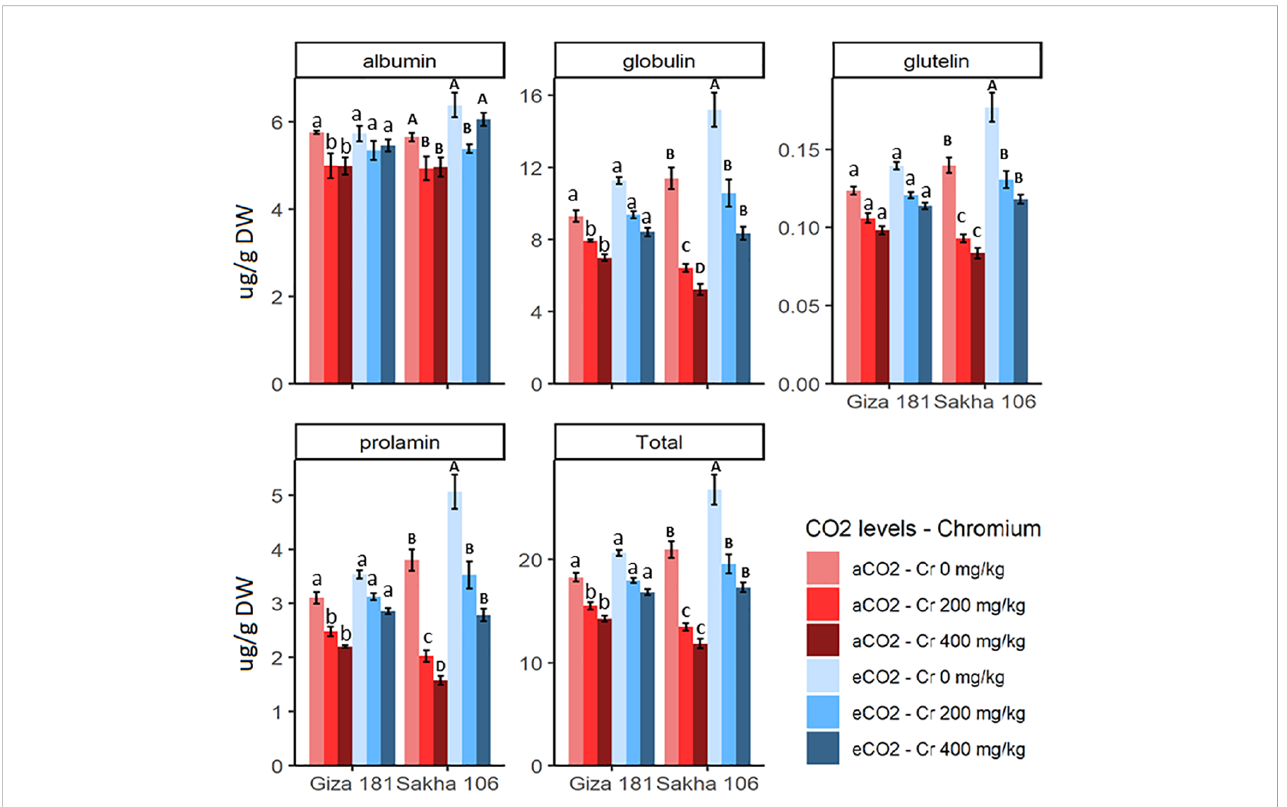
FIGURE 3 Effect of Chromium (Cr) exposure on protein pro fi le of rice grains produced under either aCO2 (410 ppm) or eCO2 (620 ppm). Values are presented as means± standard error of 4 independent replicates. Different letters within the same cultivar represent signi fi cant differences between means (Tukey's Test; P <